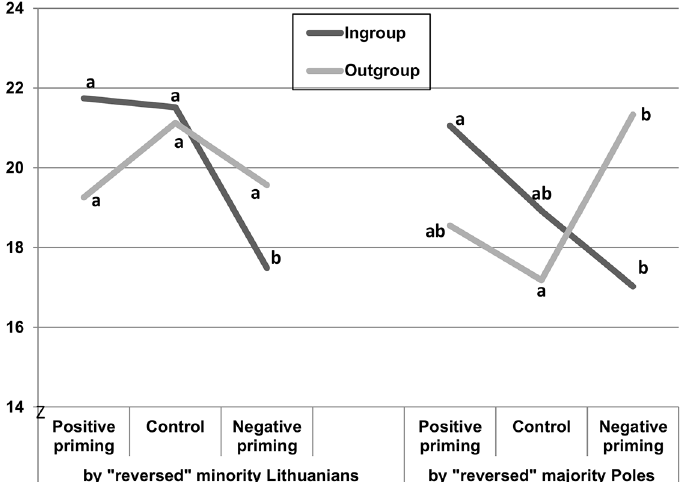
Figure 4. Degree of essentialist attribution by priming (positive vs neutral vs negative) by group status (Lithuanians vs. Poles) by target (ingroup vs